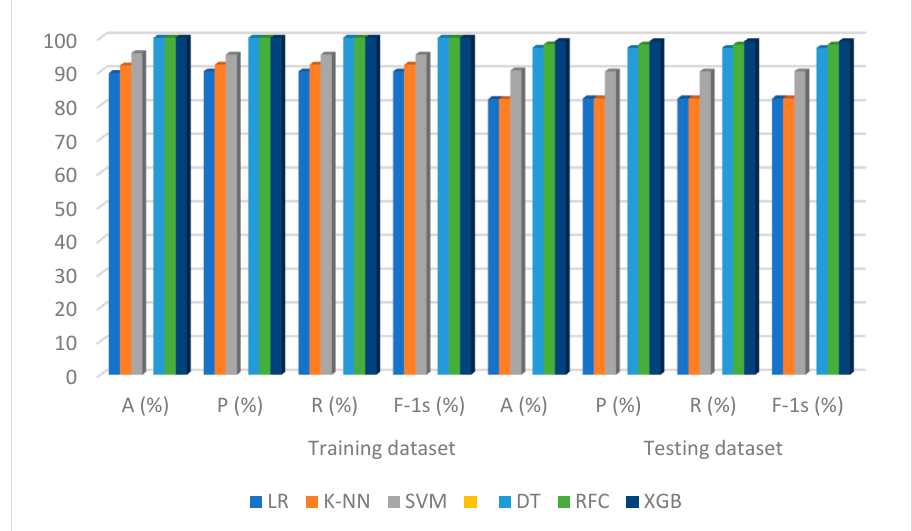
Figure 9. Graphical representation of the performance evaluation of the traditional system.